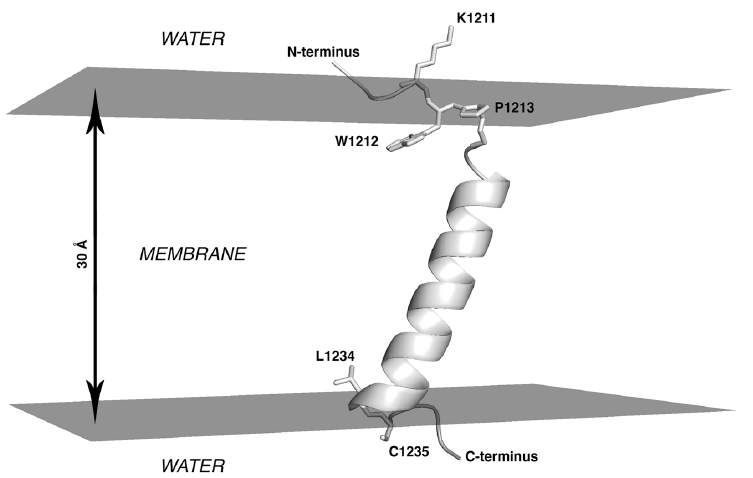
Figure 1. Lowest-energy state for monomeric S-TMD derived via Monte Carlo simulations. Spike fragment 1208–1239 in an implicit membrane is shown. The system is oriented in such a way that the top and bottom surfaces of the hydrophobic slab (here represented in grey) are perpendicular to the Z axis and correspond to XY planes with Z-coordinates of +15Å and − 15Å. The protein is shown in cartoon representation with selected residues in stick